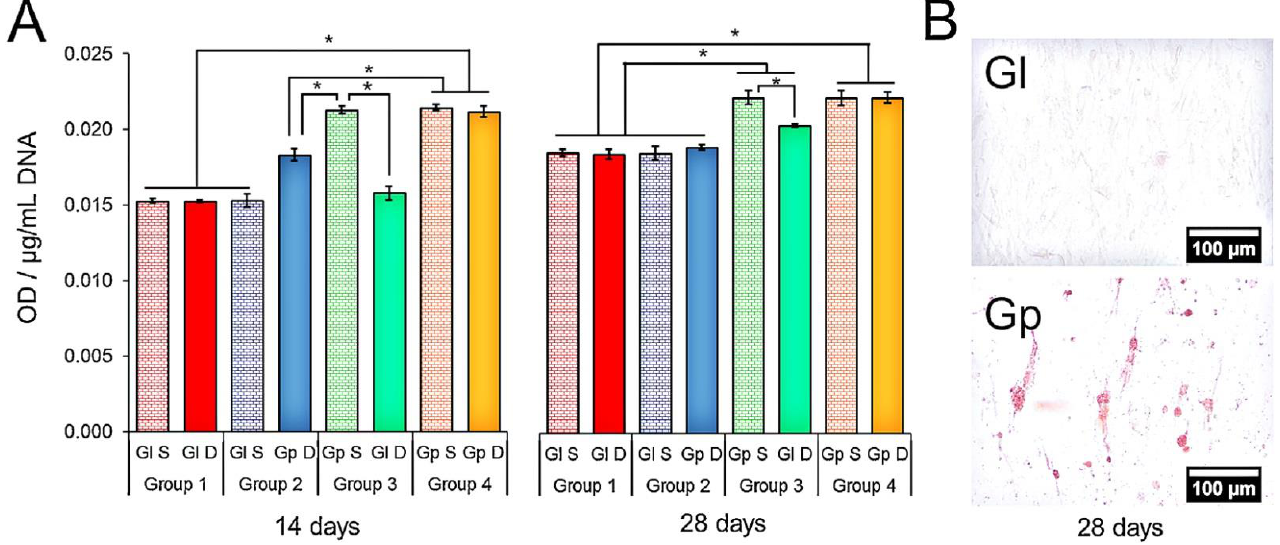
Figure 6. ( A ) Alizarin red S staining. The media obtained from DPSC on Gp increased the mineralization of cells on Gl (Group 3) after 28 days (* denotes statistical difference between the groups, p < 0.05). ( B ) Alizarin red S staining evinced the presence of calcium-rich deposits in the DPSCs cultured on Gp (28 days)